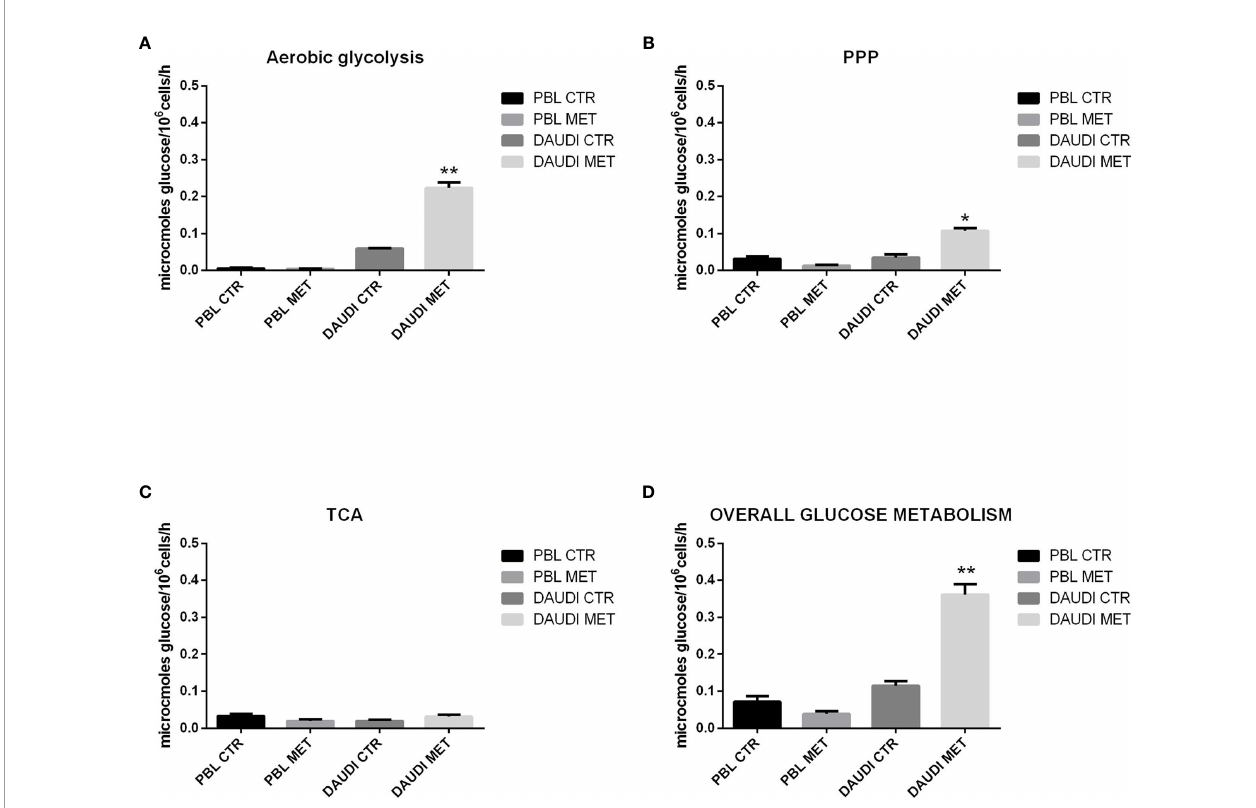
FIGURE 6 | Effect of metformin on glucose metabolism in DAUDI and PBL cells. Panel (A) represent the rates of glucose consumption in aerobic glycolysis producing lactate, while panel (B, C) show the rate of PPP and TCA. Effective rates of utilization of radiolabeled glucose in PPP and TCA cycle (Krebs) was con fi rmed by administration of [1-C 14 ]-glucose and [6-C 14 ]-glucose and subsequent monitoring of emitted 14 CO 2 , which is directly proportional to the glucose consumed. PPP rates were determined as the difference between the rates of radiolabeled carbon dioxide production from [1-C 14 ]- and [6-C 14 ]-glucose. TCA cycle rates were determined monitoring the production of radiolabeled carbon dioxide only produced by [6-C 14 ]-glucose. Overall glucose consumption (D) was calculated as the sum of glucose consumption in aerobic glycolysis, PPP and TCA cycle. CTR: untreated cells; MET: treated cells with 10mM metformin. Values are means and SEM of three independent experiments (Wilcoxon signed rank test, two-tailed ; *p-values ≤ 0.05; **p-values ≤